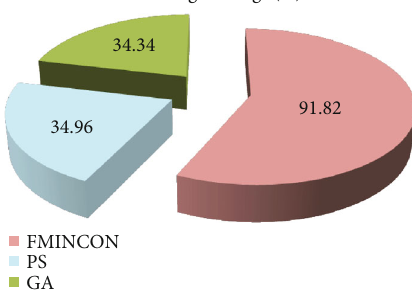
Figure 17: Cost saving of the three